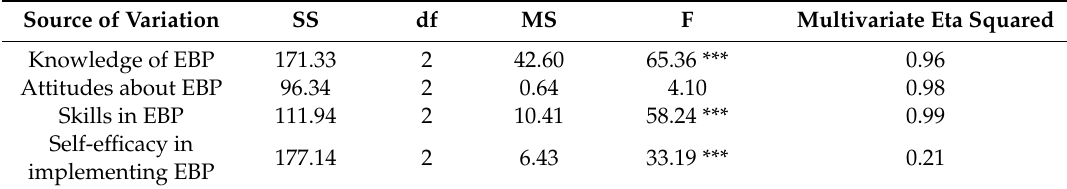
Table 5. Summary of the repeated-measures ANOVAs for each